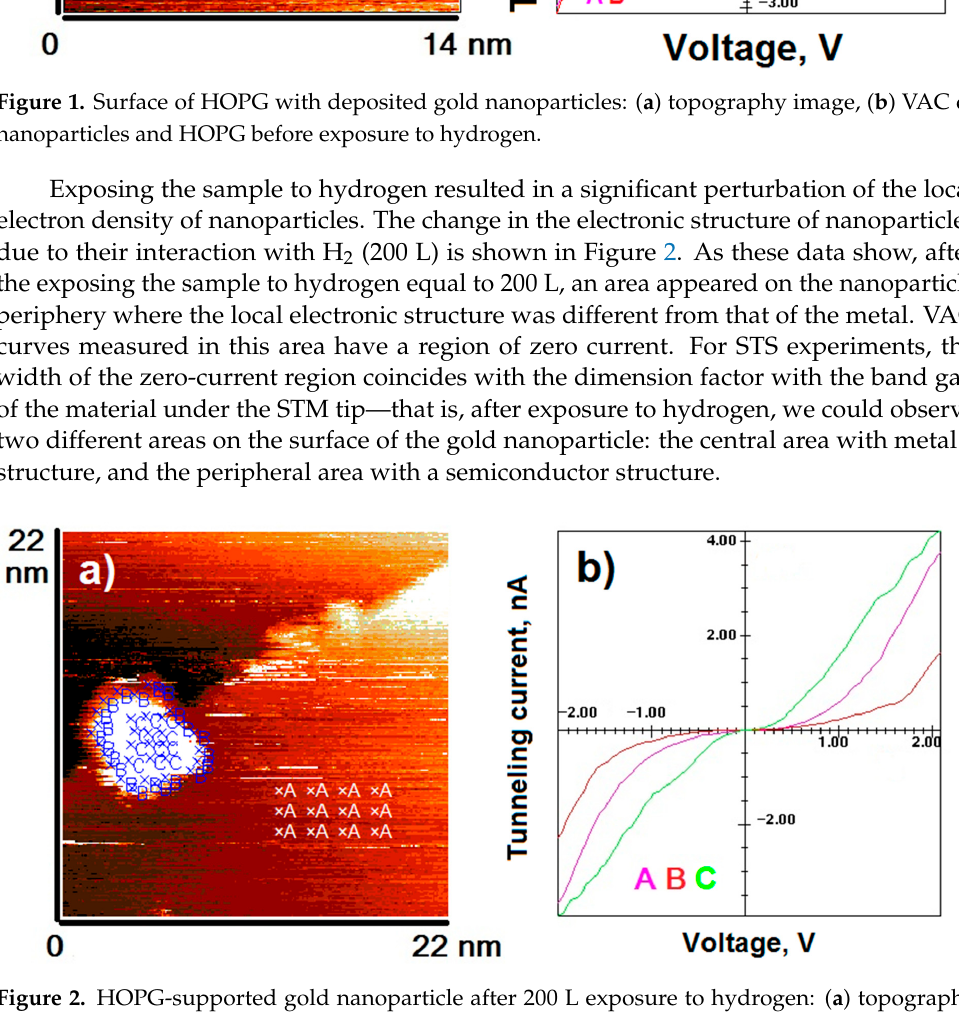
Figure 3. Variants of the inner atomic structure of hydrogenized gold nanoparticles on HOPG: ( a ) dissolution of hydro- gen atoms in gold; ( b ) formation of surface and subsurface layers of hydrogen atoms. In the case of hydrogen dissolution, HOPG-supported gold nanoparticles with pe- ripheral semiconducting areas can be described as junctions with a met- al-semiconductor-metal (MSM)-type structure. Indeed, carbon and gold with metal elec- tronic structures are separated from each other in some volume by hydrogenized gold with a semiconductor structure. Due to charging effects at the interfaces between pure and hydrogenized gold and between hydrogenized gold and carbon, the form of the potential barrier will change, and the observed band gap of hydrogenized gold will also change. Let us consider this process.